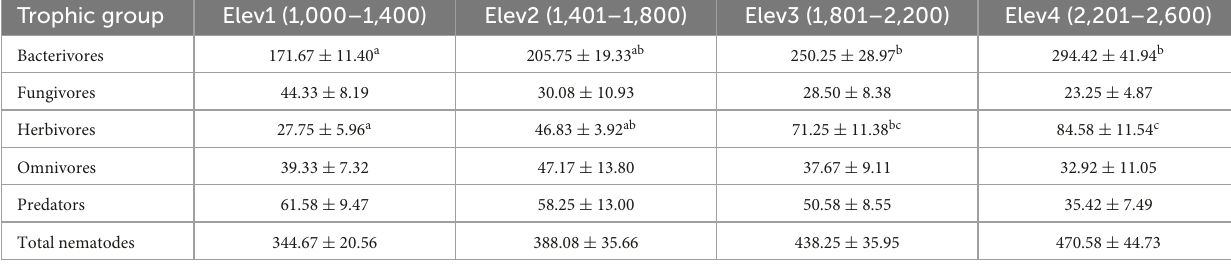
TABLE 4 Nematode abundance of various trophic groups across the studied elevation classes (mean ± standard error).